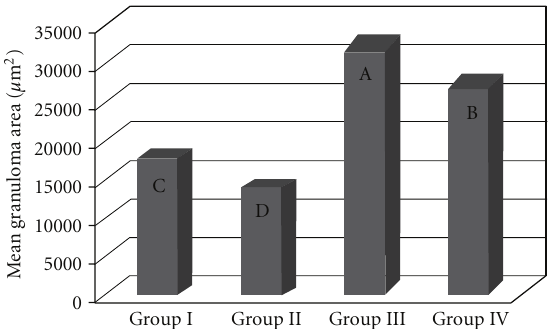
Figure 3: The area of the granulomatous response around the eggs of S. mansoni in the lungs of the mice in all 4 experimental groups (I, II, III, and IV) is depicted based on the time since the inoculation of the eggs in the caudal vein. The means with di ff erent letters exhibited a significant di ff erence ( α = 0 . 05).